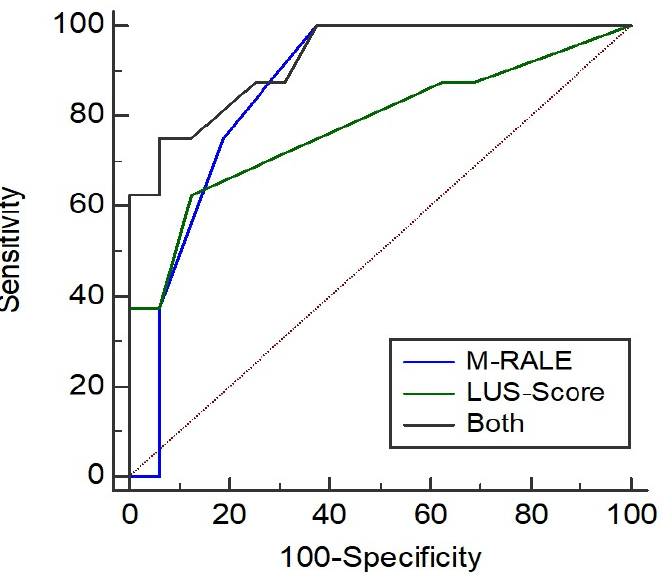
Figure 5. ROC analysis for differences between baseline and follow-up 1: M-RALE (blue line, AUC: 0.87, best cut-off point: 0, sensitivity: 100%, specificity, 61.1%), LUS score (green line, AUC: 0.79, best cut-off point: 0, sensitivity: 62.5%, specificity: 88.9%) and both added up weighted for the maximum values (black line, AUC: 0.92, best cut-off point: 0.15, sensitivity: 75.0%, specificity: 93.7%) showed a good prediction for the need of ICU treatment; no significant difference was found.